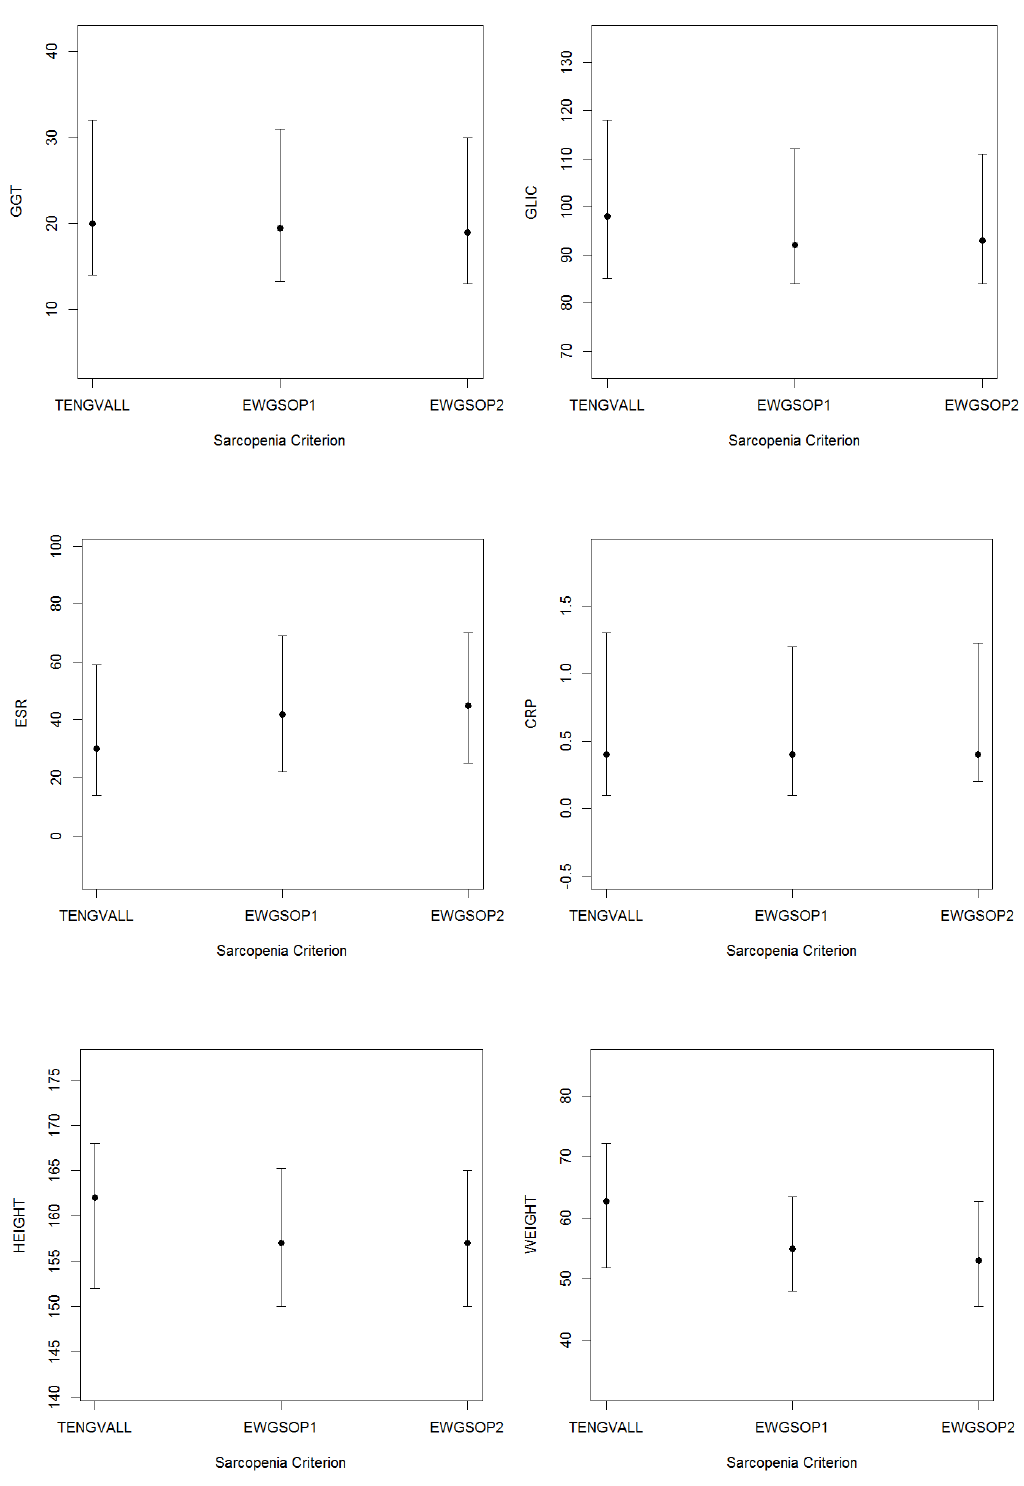
Figure A6. Summary for patients with low ASMI characteristics under each diagnostic criterion. The points represent medians, while lower and upper quartiles are represented by the vertical bars.